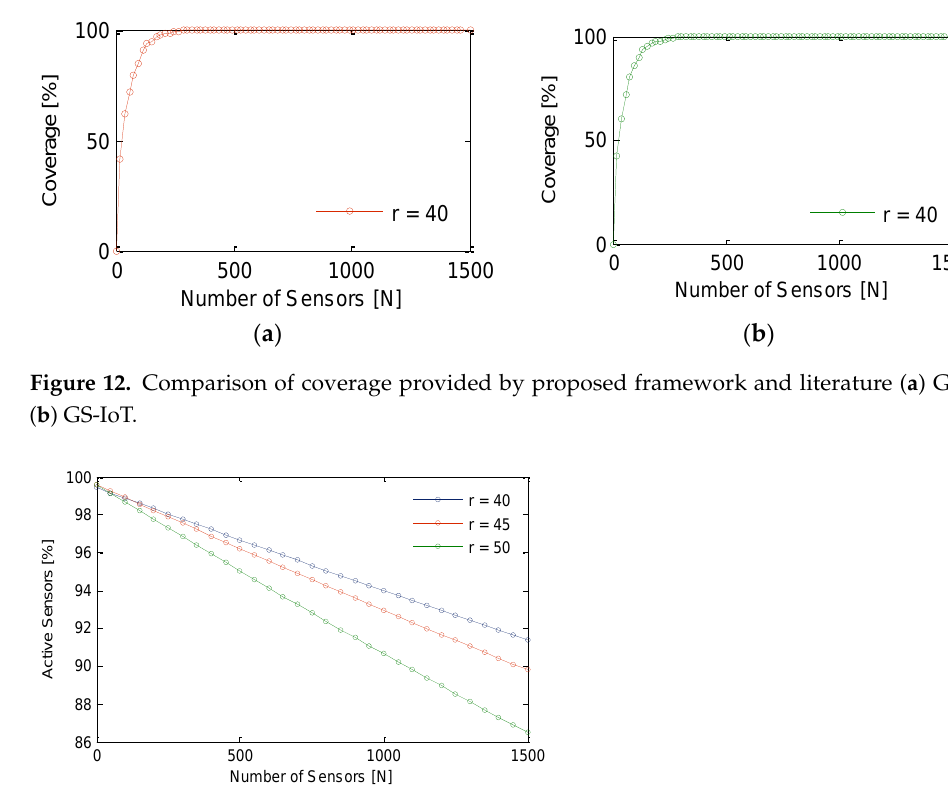
Figure 13. Performance of GS-IoT framework in setting sensor nodes off when in coordinated groups.